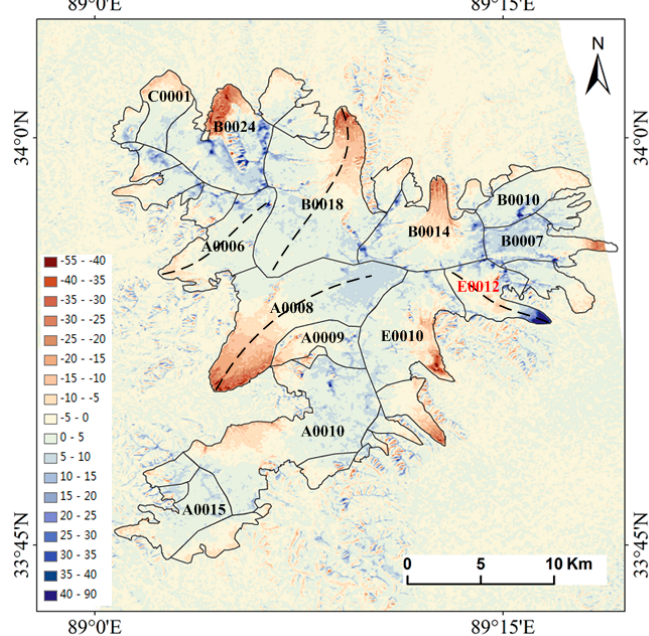
Figure 2. Elevation changes (unit: m) over the Puruogangri ice field between 2000 and 2012. Glacier outlines were delineated from a Landsat TM image. The last five codes of the WGMS IDs of the glaciers with a size exceeding 10 km 2 are presented. Glacier E0012 (WGMS ID: 5Z213E0012) is a surge-type glacier. The glacier central flow lines are indicated in dashed black.